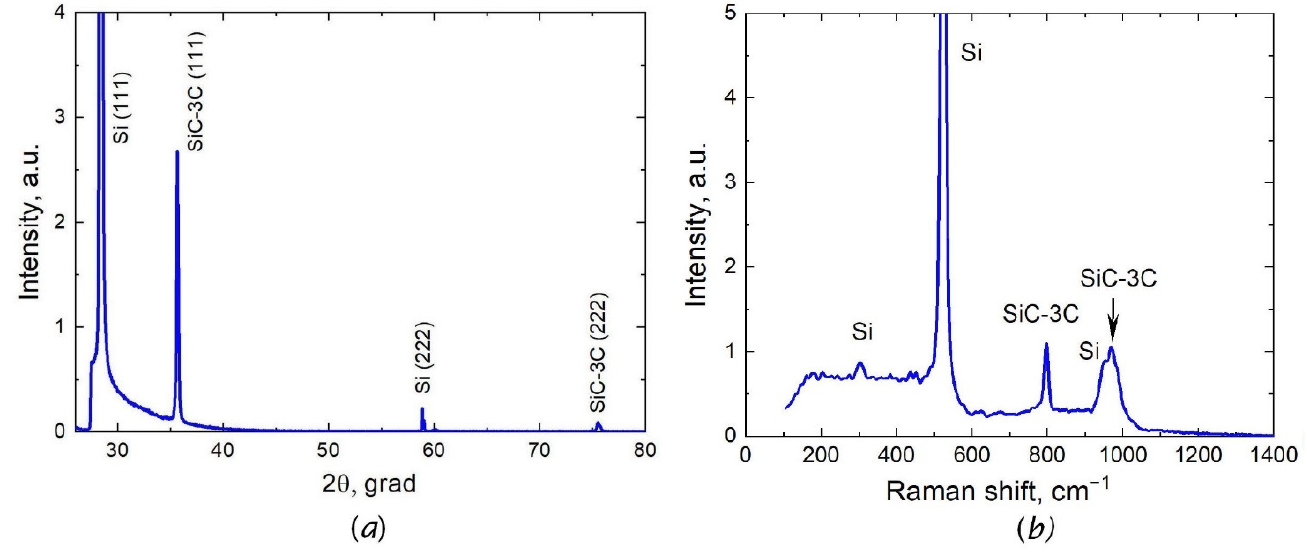
Figure 1. XRD spectrum of a 3C-SiC(111)/Si(111) hybrid substrate grown by the MCSA ( a ) and Raman spectrum of the same sample ( b ).